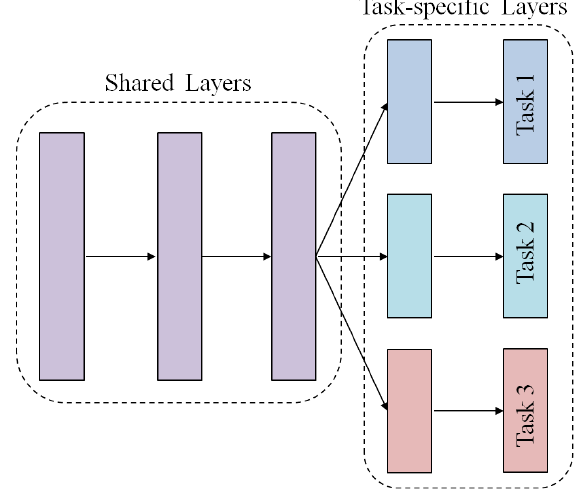
Figure 3. Hard parameter sharing in multi-task learning.